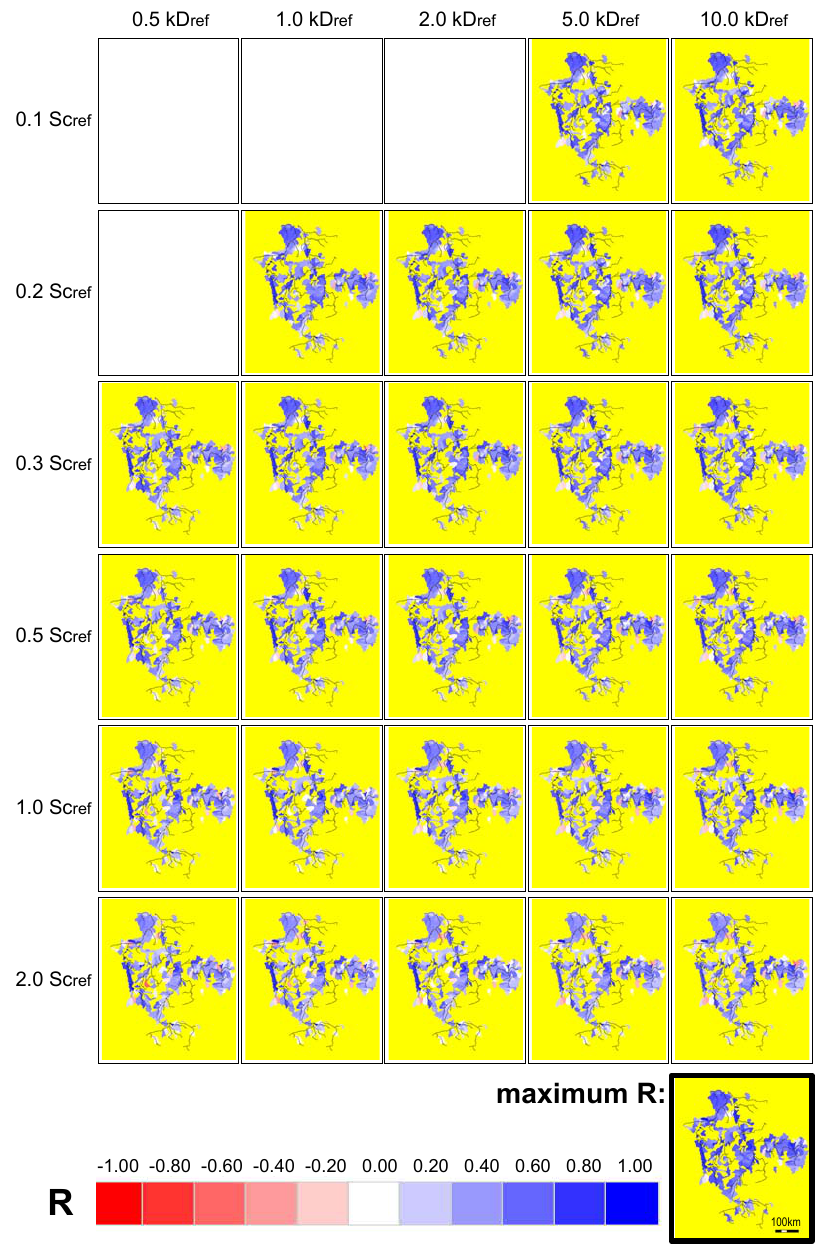
Fig. 9. The sub-basin average of timing agreement indicators, R cor , for all scenarios. To distinguish near zero values (white), we use a yellow background. The lower right corner map is a composite map of the maximum values of all scenarios. Note: some scenarios with small tranmissivities KD and storage coefficients Sy failed to